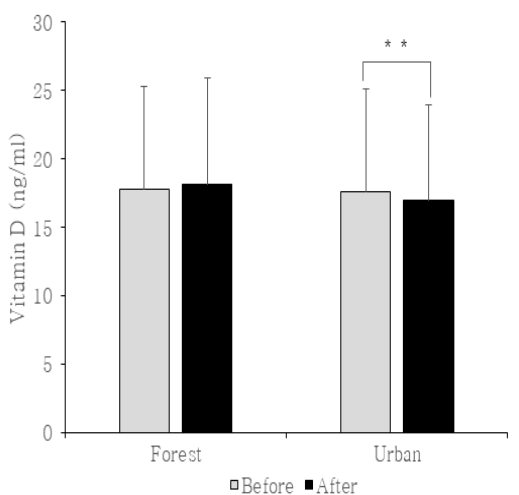
Figure 4. Changes in vitamin D levels before and after forest therapy. ** indicates significant di ff erences at p <